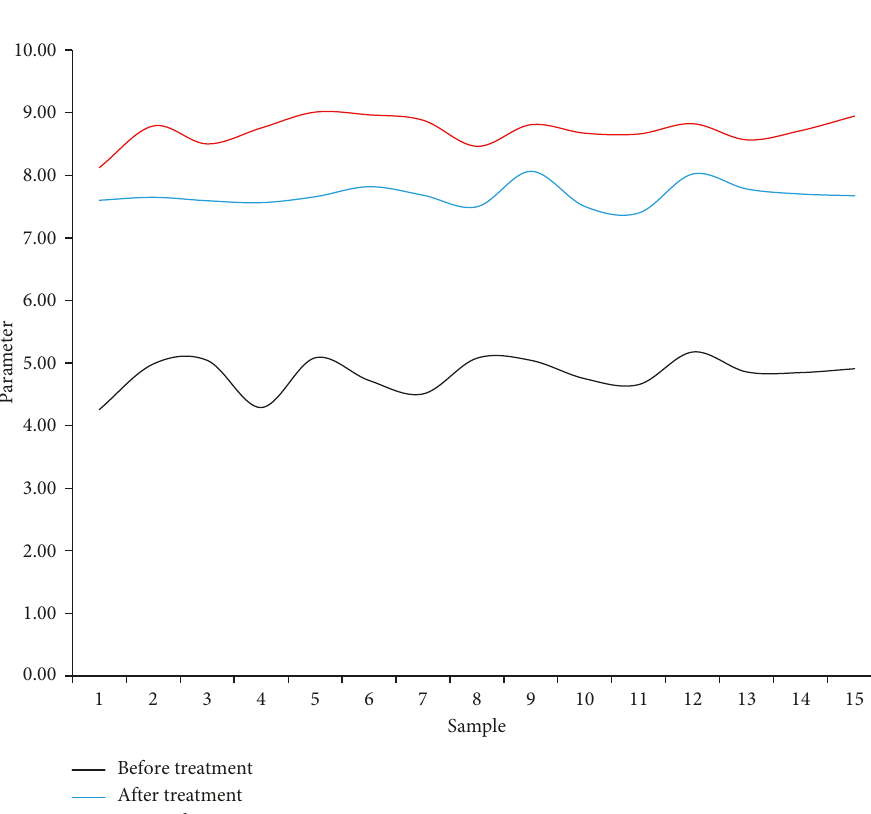
Figure 4: Membrane separation device.